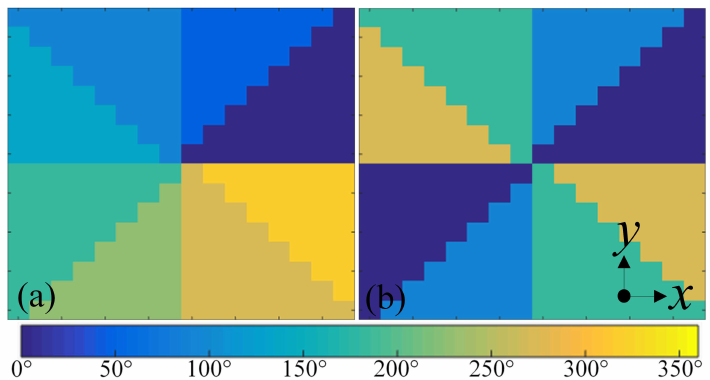
Figure 5. The front view of the transmission phase distribution schemes at 5.14 GHz for generating beams carrying OAM of different orders: ( a ) l = + 1. ( b ) l = +